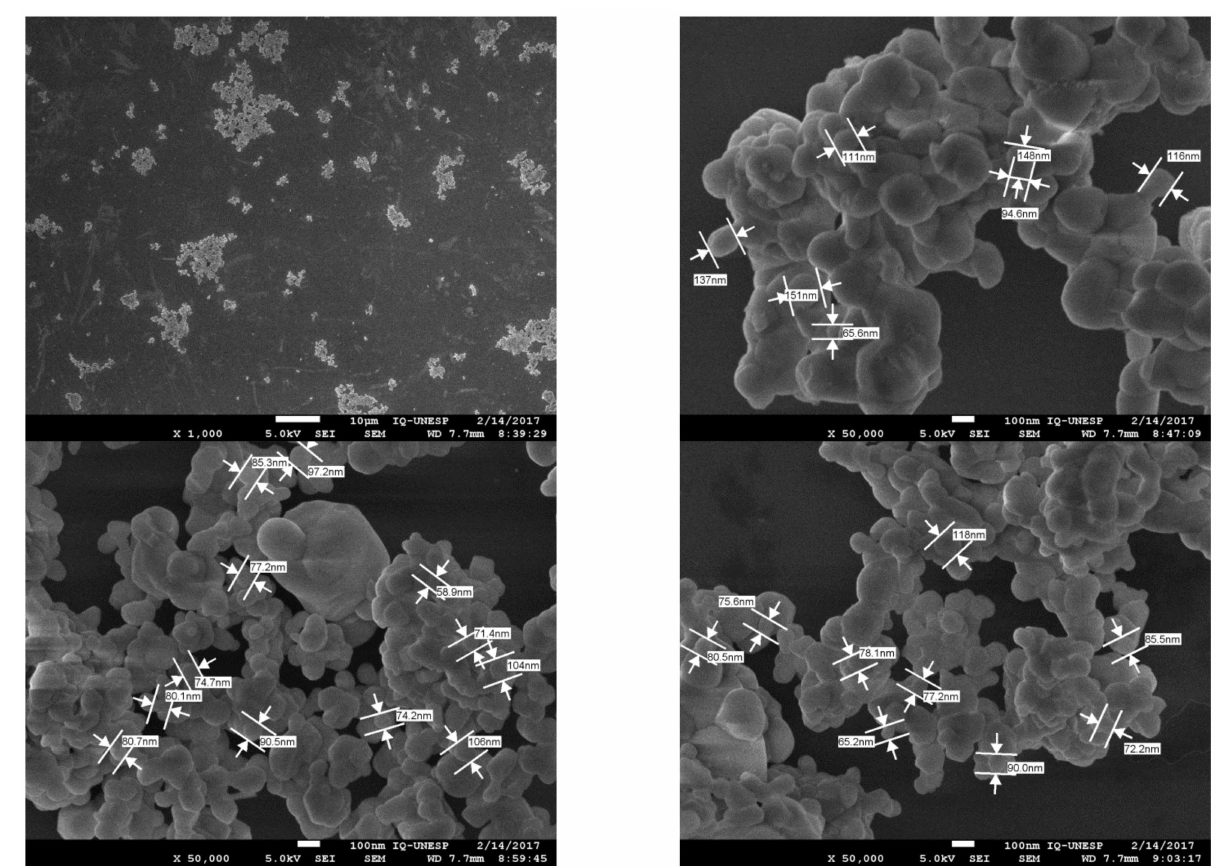
Figure 5. SEM images of the PZT particles obtained via Pechini’s method highlighting the dimensions of some individual